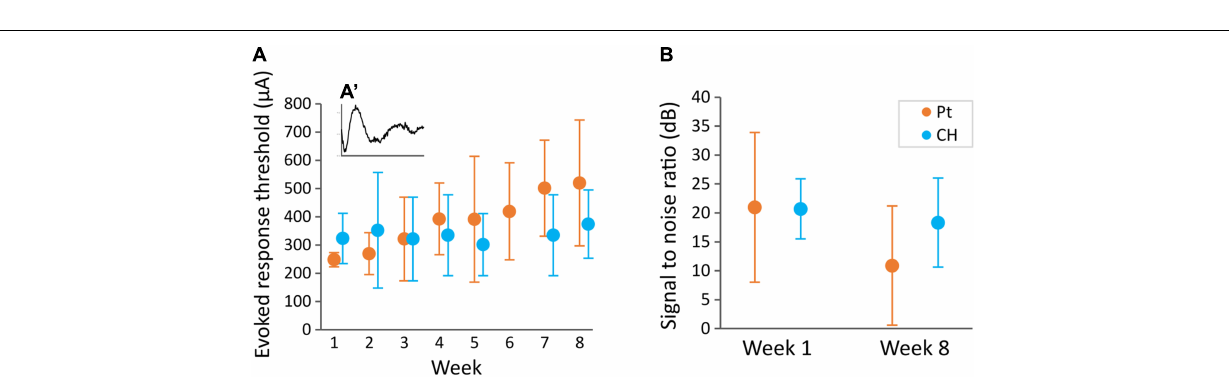
FIGURE 8 | Charge storage capacity (CSC) of conductive hydrogel-coated (CH) and uncoated platinum (Pt) electrodes tested weekly in the rat brain. Cyclic voltammetry was measured between –0.6 and 0.8 V for six cycles using a potentiostat. CSC was calculated as the average area inside the cyclic voltammetry traces. (A) Representative cyclic voltammetry traces of CH and Pt electrodes at the start (w1) and the end (w8) of chronic implantation. (B) Mean charge storage capacity ± SD measured in vivo . CH had significantly higher charge storage capacity ( p < 0.001, three-way ANOVA, 28 Pt electrodes, 24 CH electrodes) across all the electrode contacts for the duration of the study. There was no significant effect of duration of implantation ( p = 0.106), or interaction between coating and duration of implantation ( p = 0.108).